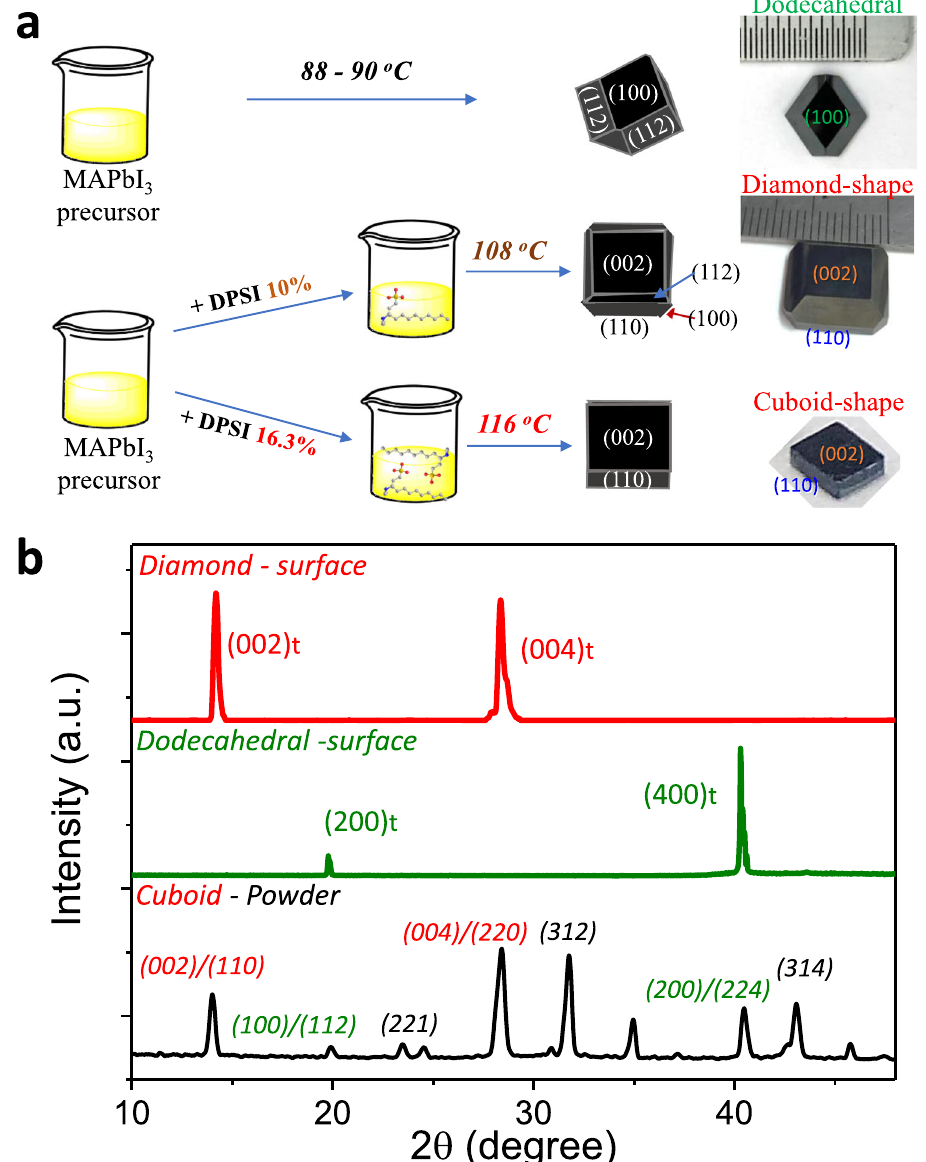
Fig. 1 Crystal growth behavior with ligand regulation. a Scheme of crystals growing process and conditions, and photographs of the grown crystals. b XRD patterns of the facets of the crystals and powder of the cuboid-shape